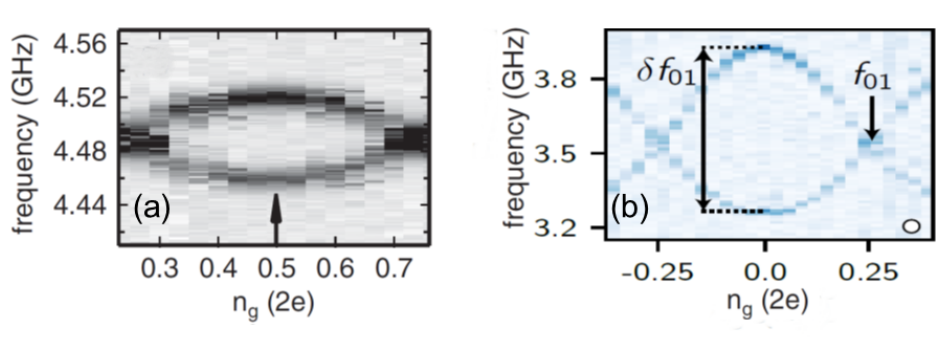
Figure 1: Panel (a) copied from Ref. [ 8 ] . Spectroscopy of a qubit as a function of gate-induced charge n . For each pixel, a Gaussian pulse ( σ = 20 ns, corresponding g to a pulse on resonance) is applied at the indicated frequency and the qubit is imme- diately measured. Each pixel is an average of 5000 repetitions (50 ms). Darker pixels correspond to higher homodyne readout voltages that are proportional to the prob- ability of the qubit in the excited state. An “eye”-shaped pattern indicates charge- e jumps associated with the tunneling of nonequilibrium quasiparticles. Panel (b) copied from Ref. [ 9 ] . Normalized two-tone spectroscopy measurements of the 0 → 1 transition versus the offset